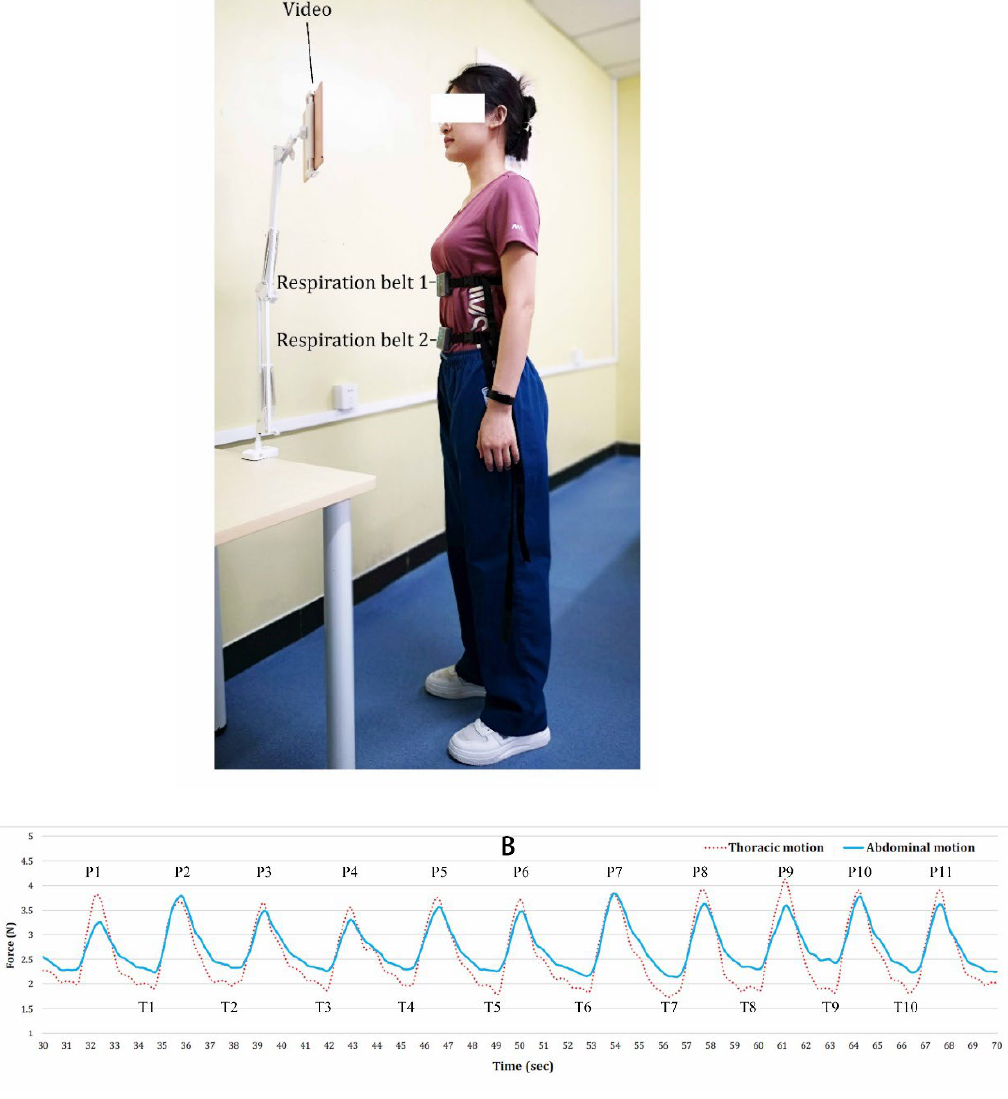
Figure 1. ( A ) Respiration testing. Respiration belt 1 was fastened at the height of the xiphoid; respiration belt 2 was fastened at the height of the navel; a neutral video was playing. ( B ) Wave lines of respiration. The force was generated by the stretch of respiratory movement; solid line represents the abdominal motion; dotted line represents the thoracic motion. P = peak; T =